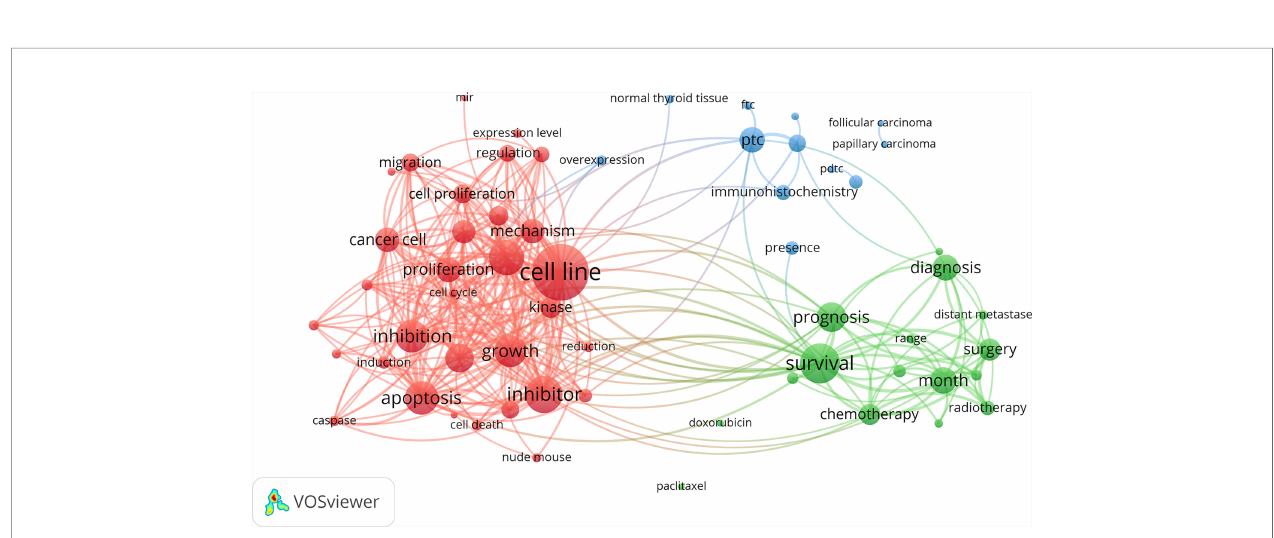
FIGURE 7 | Clustering network of terms in ATC publications from 1997 to 2020. The most common terms used in the scienti fi c literature were investigated to identify relationships among the extracted terms. Terms were automatically exacted from titles and abstracts and divided into clusters by natural language processing techniques of